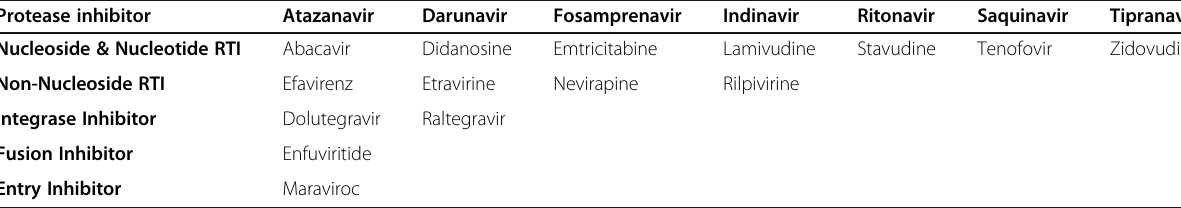
Table 1 PBS list of HIV medications. RTI = Reverse transcriptase inhibitors